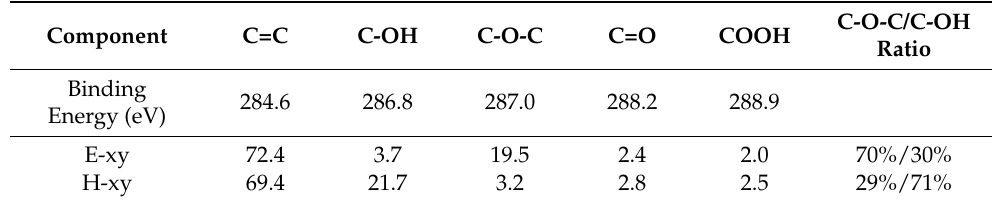
Table 1. Relative concentrations of the main four functional groups determined for E-xy and H-xy graphene